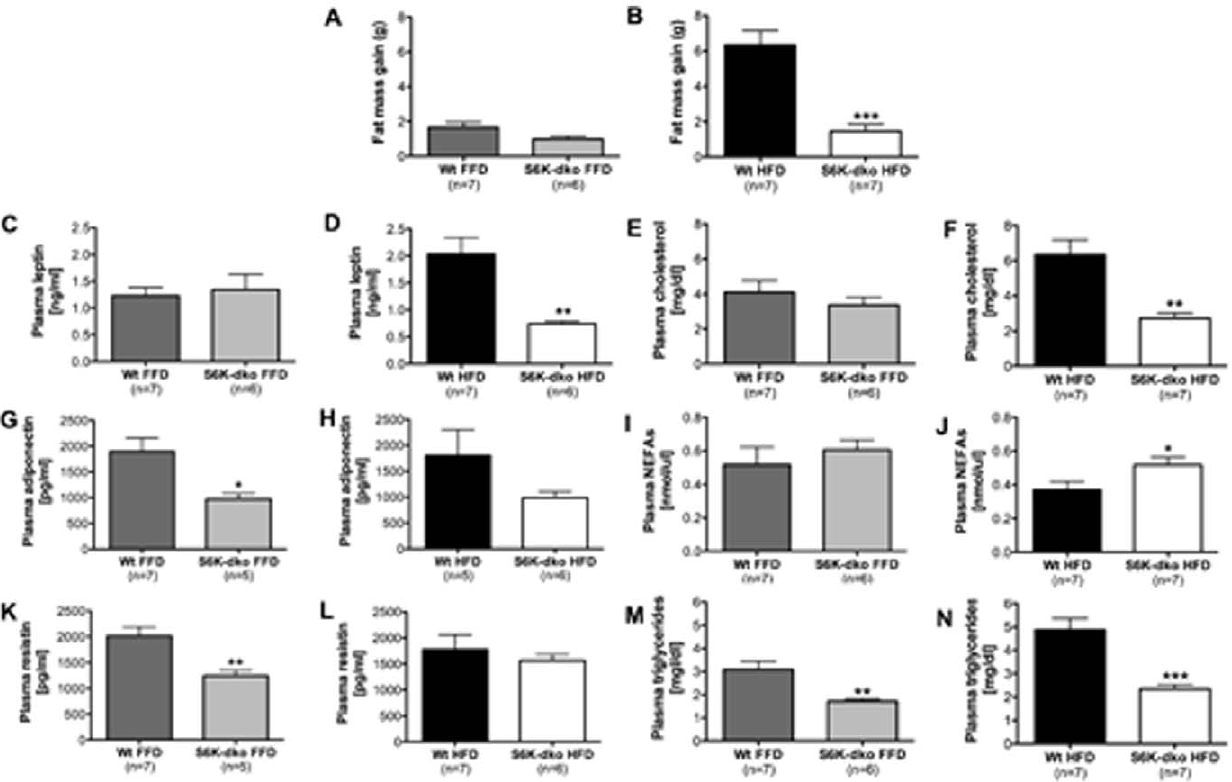
Figure 5. S6K-dko plasma biochemistry. S6K-dko mice fed a high-fat diet show significantly lower fat mass gain (B), plasma leptin (D), cholesterol (F) and triglycerides (N), as well as higher free fatty acids (J) compared to wt controls. When fed a fat-free diet, S6K-dko mice still show significantly lower plasma triglycerides (N), as well as significantly lower adiponectin (H) and resistin (K) levels. FFD, fat-free diet; HFD, high-fat diet; NEFAs, non-esterified fatty acids. Two-tailed t test * P , 0.05, ** P , 0.01, *** P , 0.001.